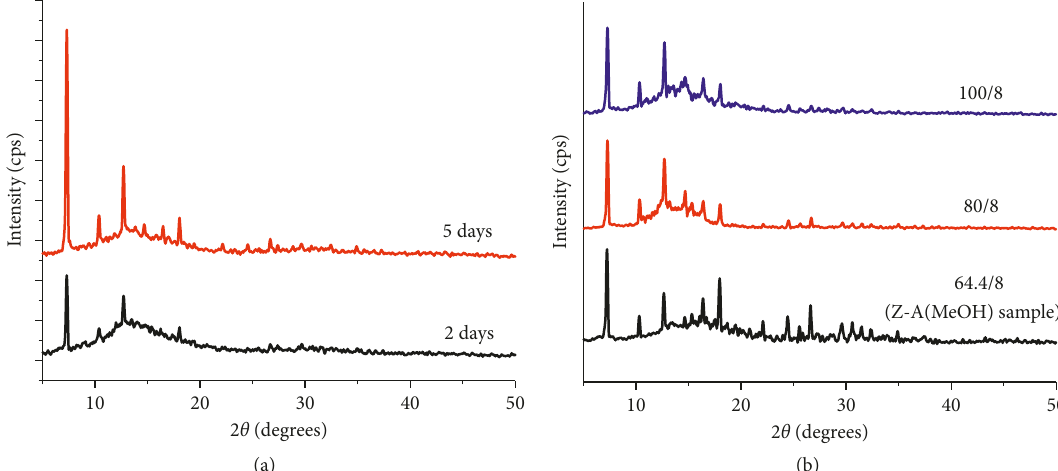
Figure 7: XRD patterns of ZIF-8 crystals synthesized with process A: (a) different synthesis times; (b) different meIm/Zn molar ratios.